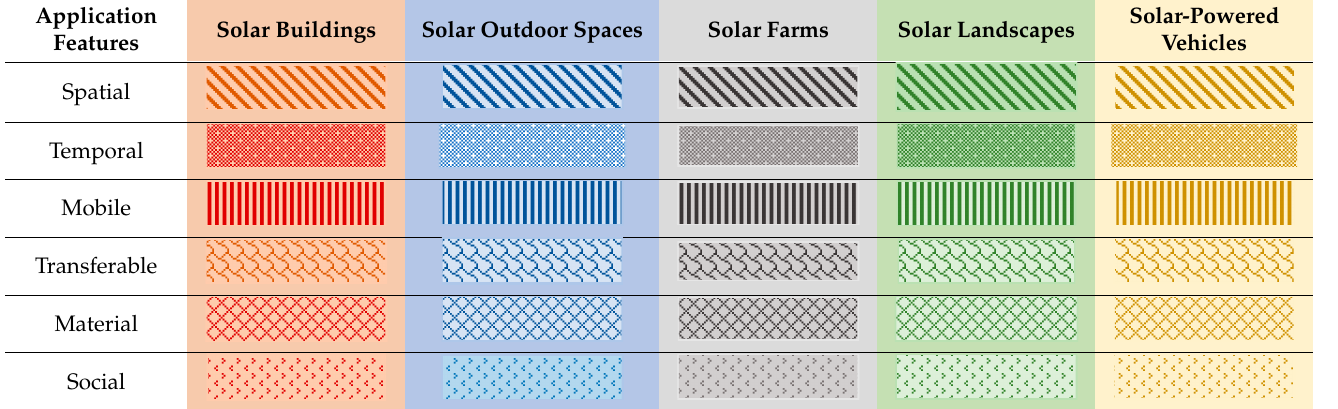
Table 1. Solar Architecture Table template.